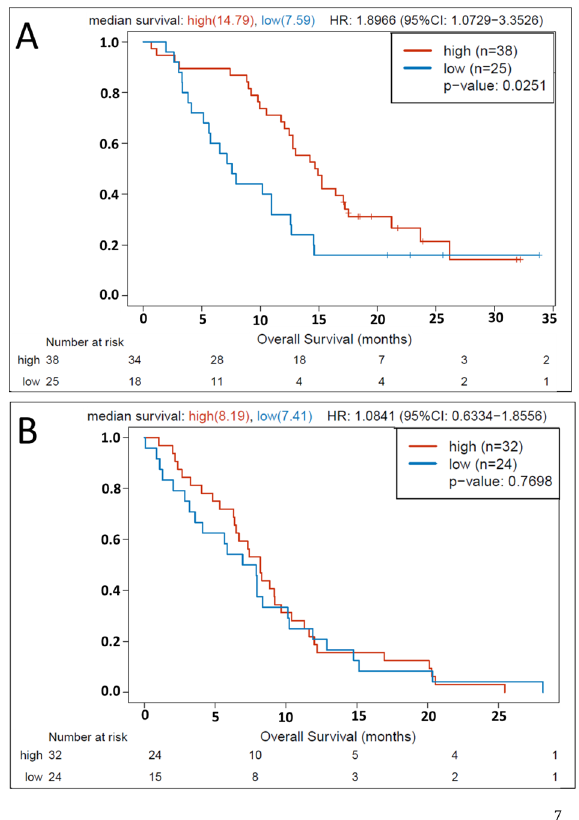
Figure 3. GATA6 IHC prediction of OS in advanced PDAC according to receipt of chemotherapy [ A : in patients receiving first-line modified FOLFIRINOX (mFFX); B : in patients receiving gemcitabine–nabpaclitaxel